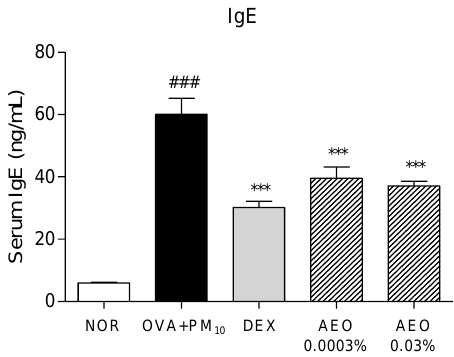
Figure 4. AEO reduced serum IgE levels in OVA+PM 10 -induced allergic rhinitis mice. The data are presented as the means ± standard error of the mean. ### p < 0.001 compared to the NOR group. *** p < 0.001 compared to OVA+PM 10 group.